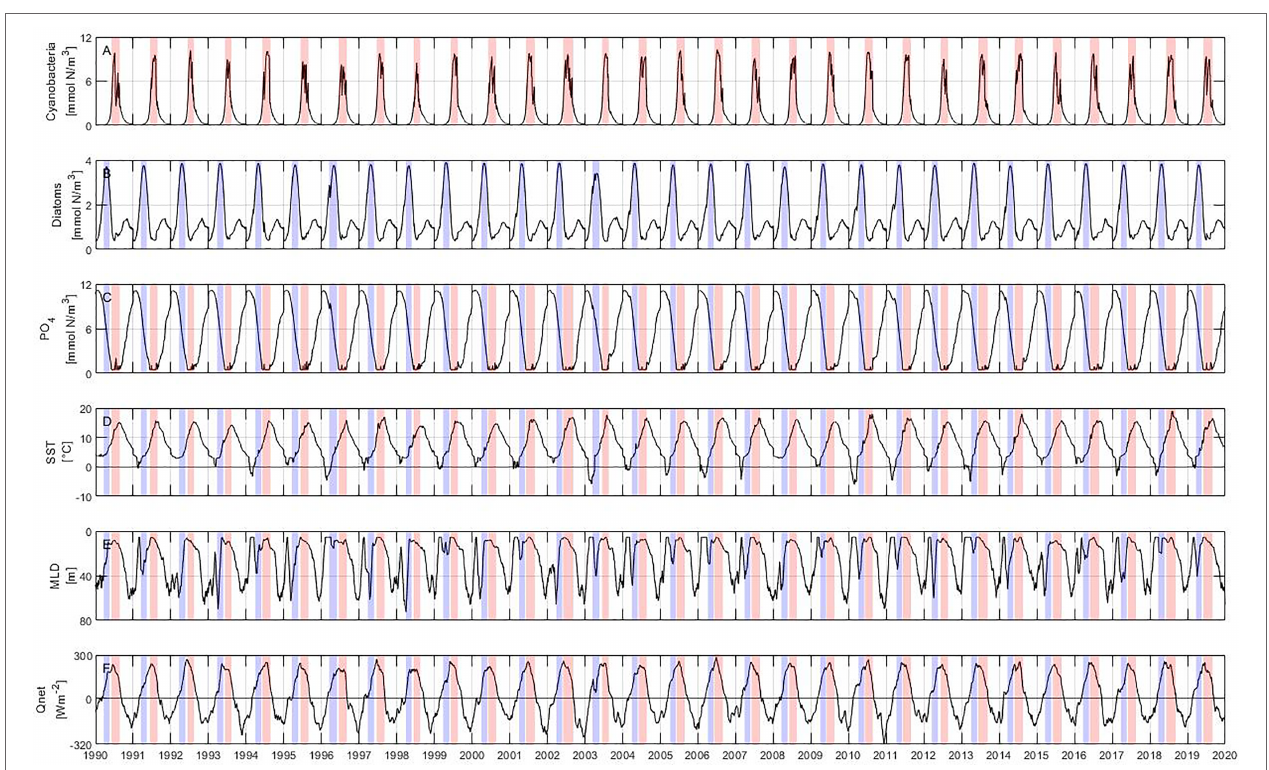
FIGURE 3 | Model results: (A) cyanobacteria, (B) diatoms, (C) phosphate concentration calculated from nitrogen using N:P ratio, (D) sea surface temperature (SST), (E) mixed layer depth (MLD) and (F) net heat flux (Qnet). The blue and red bars represent periods of diatom and cyanobacteria blooms,